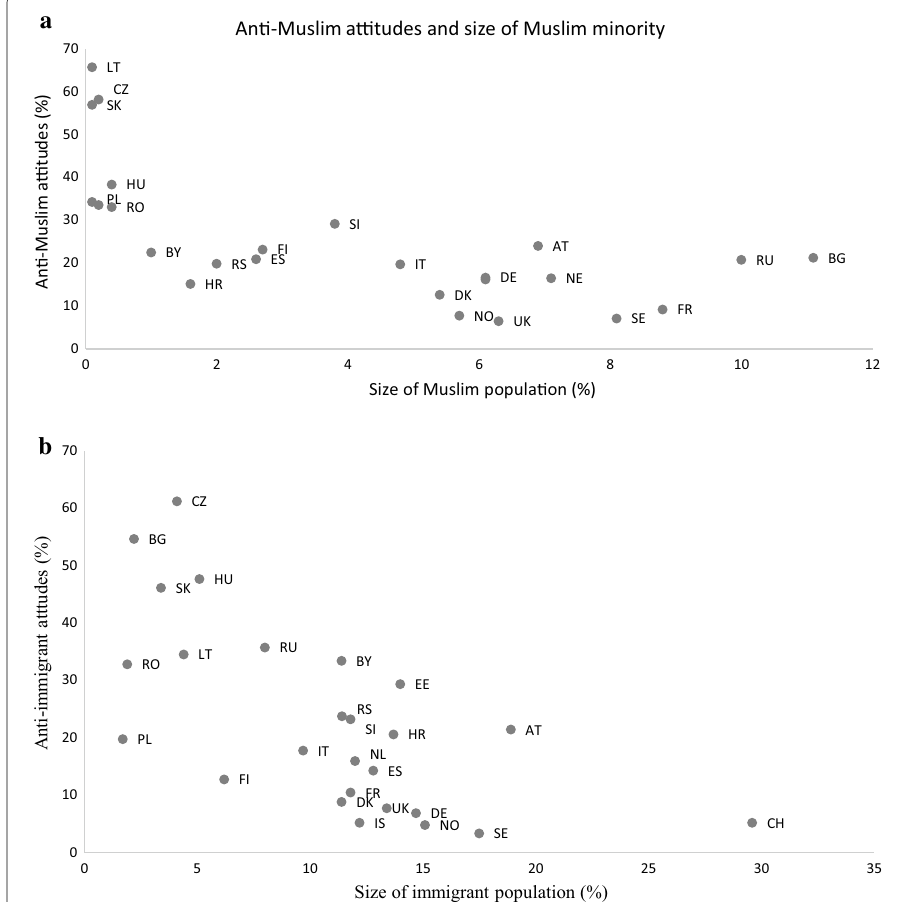
Fig. 4 a Anti-Muslim attitudes and size of Muslim minority (excluding Iceland) (For a better viewing of the figure, we have removed overlapping labels. This includes Switzerland, which has a nearly identical position to Germany, and Estonia, which overlaps Poland.). b Anti-immigrant attitudes and size of immigrant